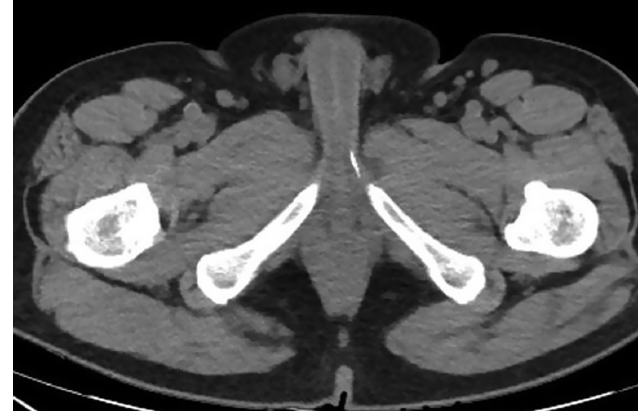
Figure 3. Computed tomography images showing single calcified Peyronie's plaques on left proximal sides of the penis.